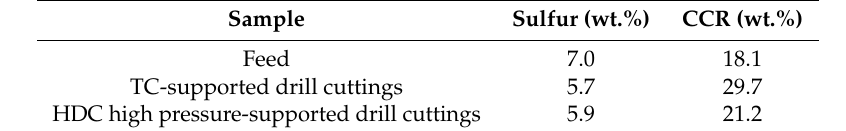
Table 6. Sulfur and Conradson carbon residue (CCR) content of the Athabasca vacuum residue Athabasca vacuum residue (AVR) feed and upgraded oil samples.